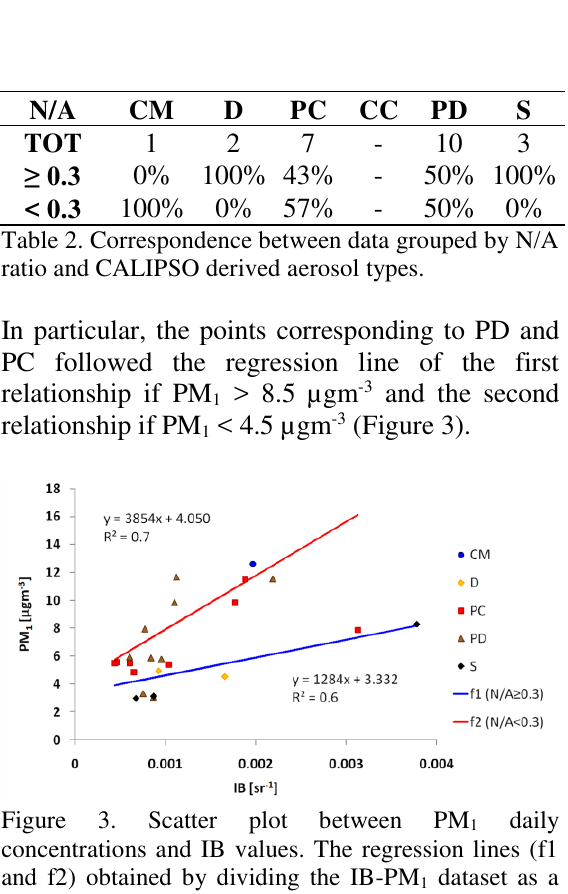
concentrations was observed in most of the